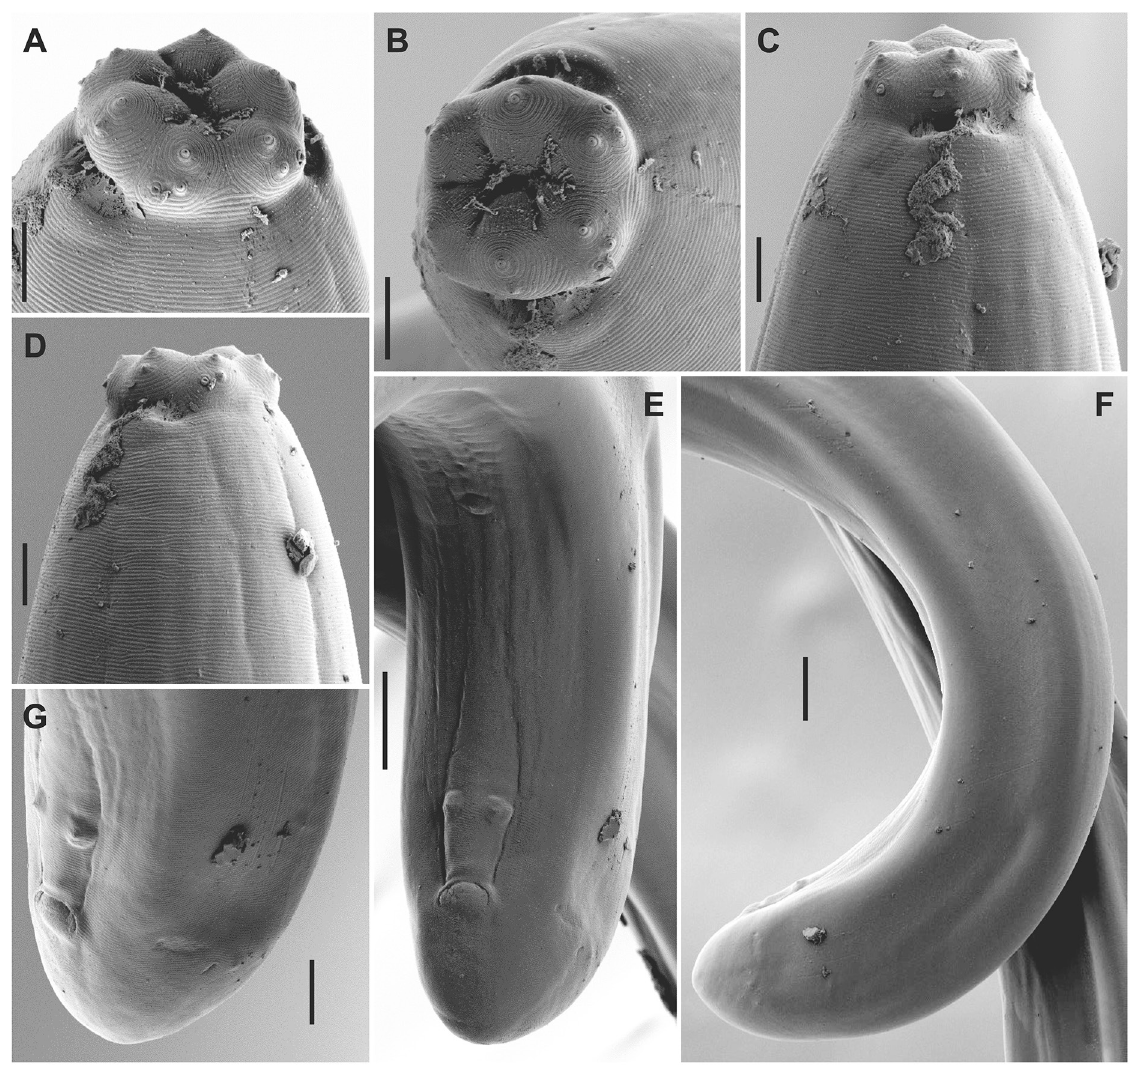
Fig. 4. Sectonema tropicum sp. nov. (SEM, ♂). A . Lip region in ventral view. B . Lip region in frontal view. C . Lip region in lateral view. D . Lip region in sublateral view. E . Posterior body region in ventral view. F . Posterior body region in lateral view. G . Caudal region in sublateral view. Scale bars: A–D = 5 μm; E–F = 20 μm; G = 10